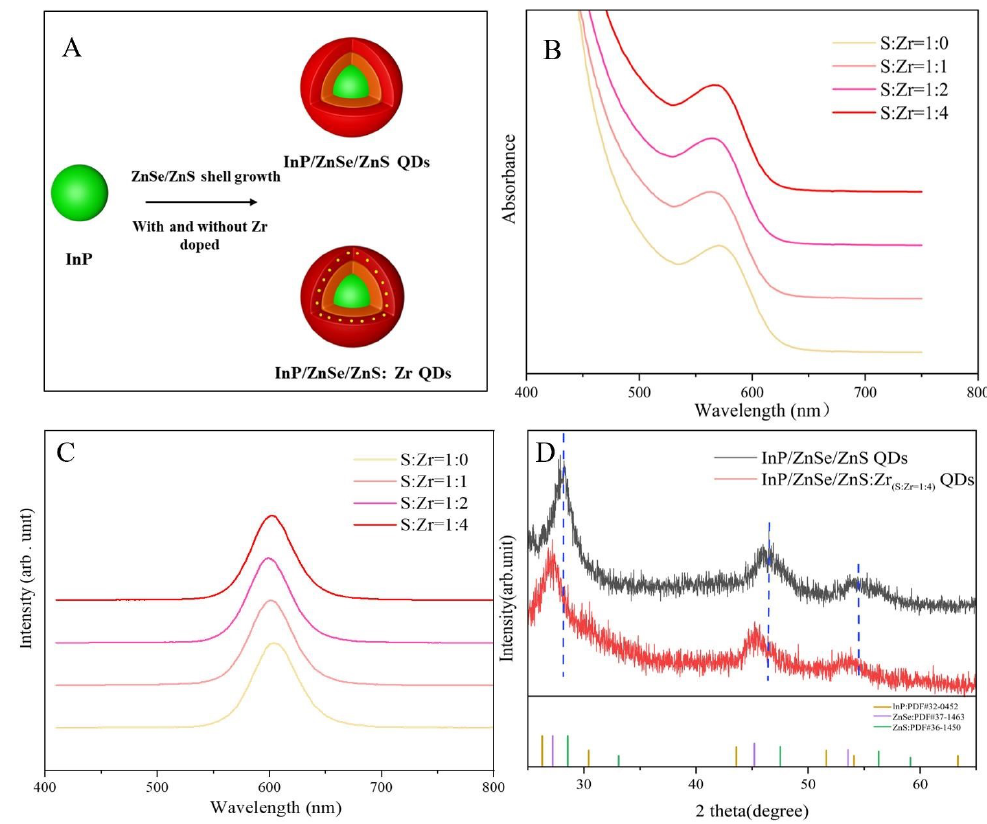
Figure 1. ( A ) Schematic of the synthesis of QDs. ( B ) UV-vis absorption and ( C ) PL spectra of QDs with different S/Zr ratios. ( D ) XRD patterns of